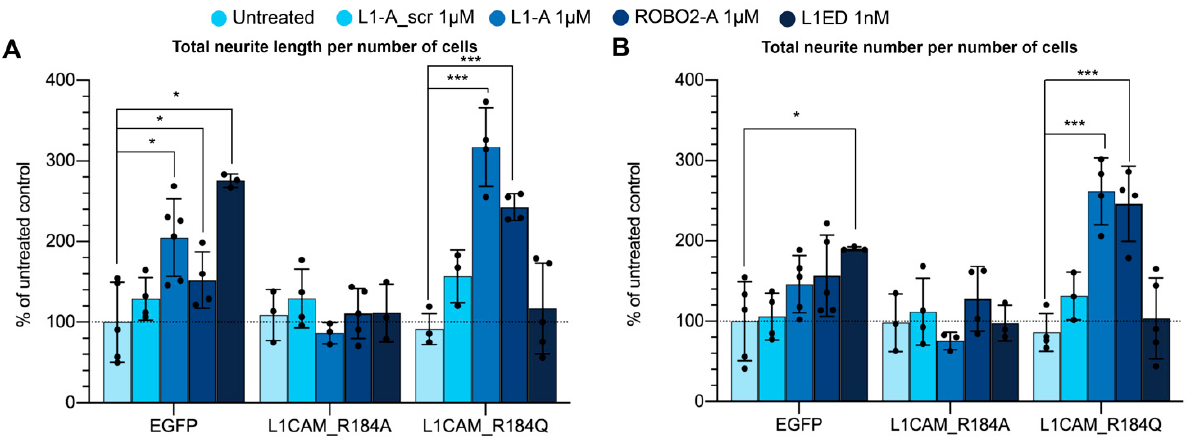
Figure 6. Rescue of CRASH cell phenotype by treatment with L1-A. ( A ) Total neurite length per number of cells and ( B ) neurite number per number of cells of proliferating SH-SY5Y cells transfected with indicated L1CAM mutants and treated with peptides. All data represent the mean ± SD of at least three independent experiments. Statistical analysis was performed using one way ANOVA with Tukey’s correction; significance at p < 0.05 (*), and p < 0.0001 (***) between samples is reported.